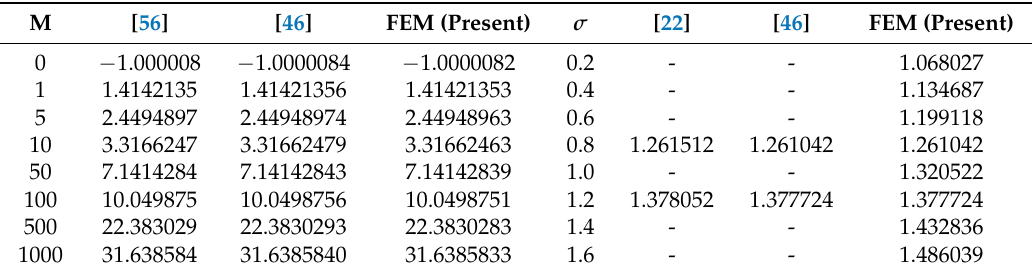
Table 4. Comparison of − f (cid:48)(cid:48) ( 0 ) for various values of M and σ ( f w = λ 1 = λ 2 = λ 3 = k p = S f = 0;).